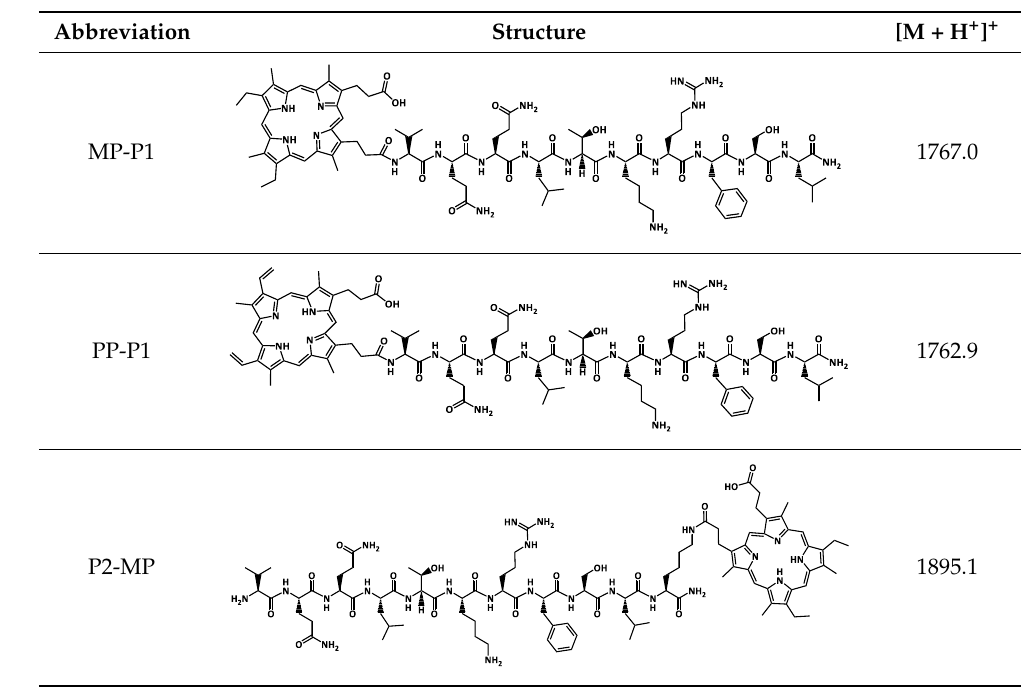
Table 1. PPCs used in the study.